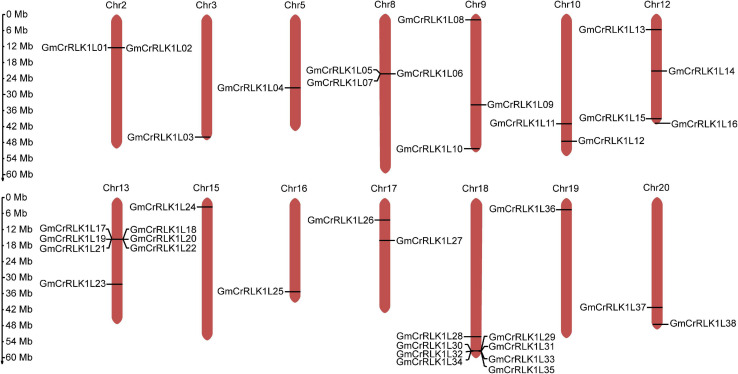
Chromosome distribution of the 38 GmCrRLK1L genes. Chromosome location map drawn with MG2C software. GmCrRLK1L genes distribution on 14 soybean chromosomes.